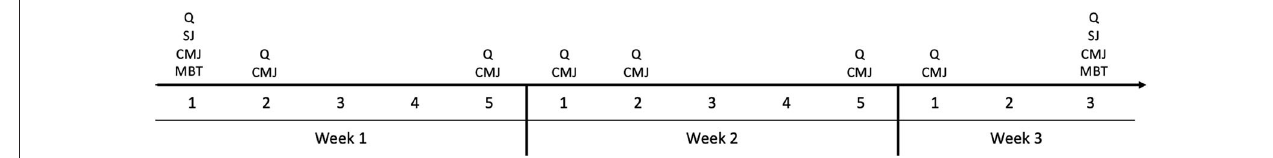
FIGURE 1 | Timeline of study design. Q, questionnaire; SJ, squat jump; CMJ, countermovement jump; MBT, medicine-ball throw.